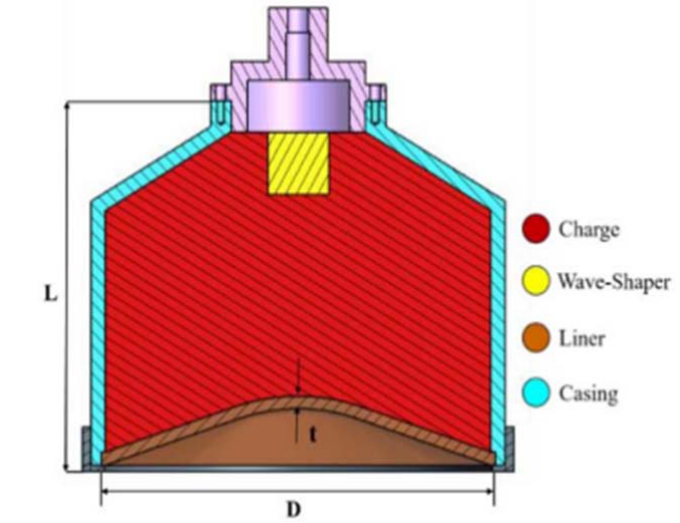
Figure 1. The schematic of EFP configuration